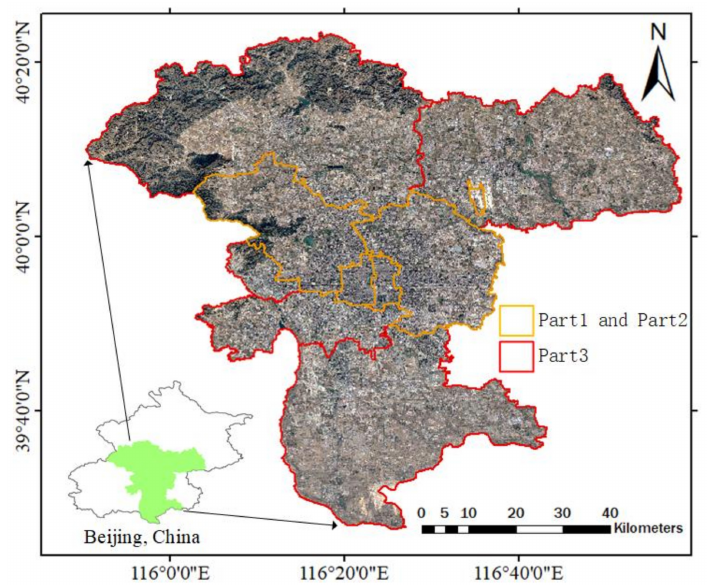
Figure 3. The first and second parts of the sample are both taken from the yellow area. The first part is the training and testing set. The second part is the unlabeled dataset. The third part is taken from the blue area for the generalization ability test.